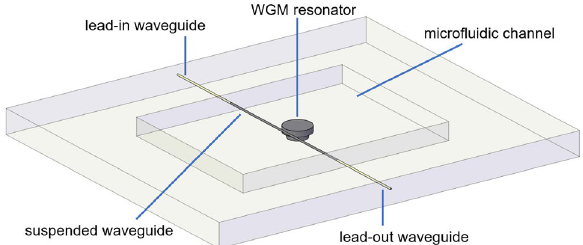
Figure 1. Schematic of the device. The microfluidic channel, containing the WGM resonator and the suspended waveguide, is first fabricated by fs-laser direct writing followed by chemical etching and